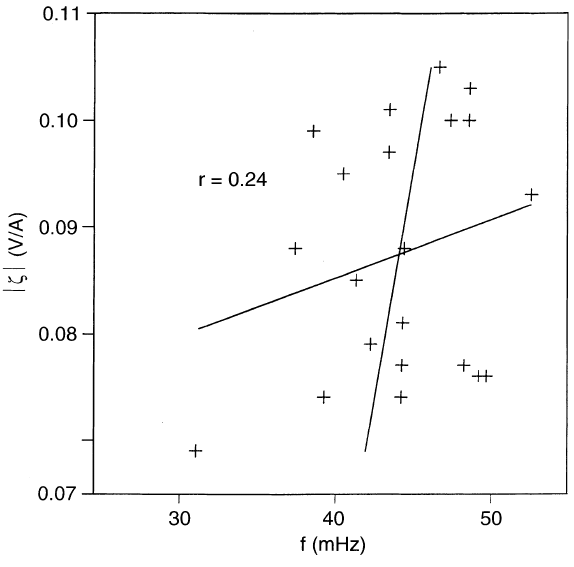
Fig. 4. Magnetotelluric sounding at the same latitude on the same date magnetosphere (e.g., Aubry, 1970; Jacobs, 1970; Orr, 1973; Orr and Matthew, 1971; Nishida, 1978). Accord- ing to Eq. (6) d l g (cid:113) = dL ’ (cid:255) 0 : 9 at L ’ 2, which is not in contradiction with direct and indirect measurements (e.g., Carpenter and Anderson, 1992).